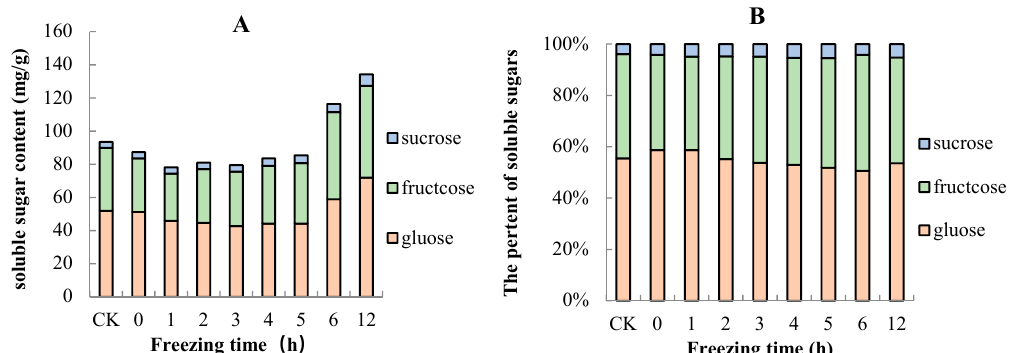
Figure 7. Changes in total soluble sugar content ( A ) and percentage composition of soluble sugars ( B ) in “Ruaner” pear during the freezing–thawing stage.